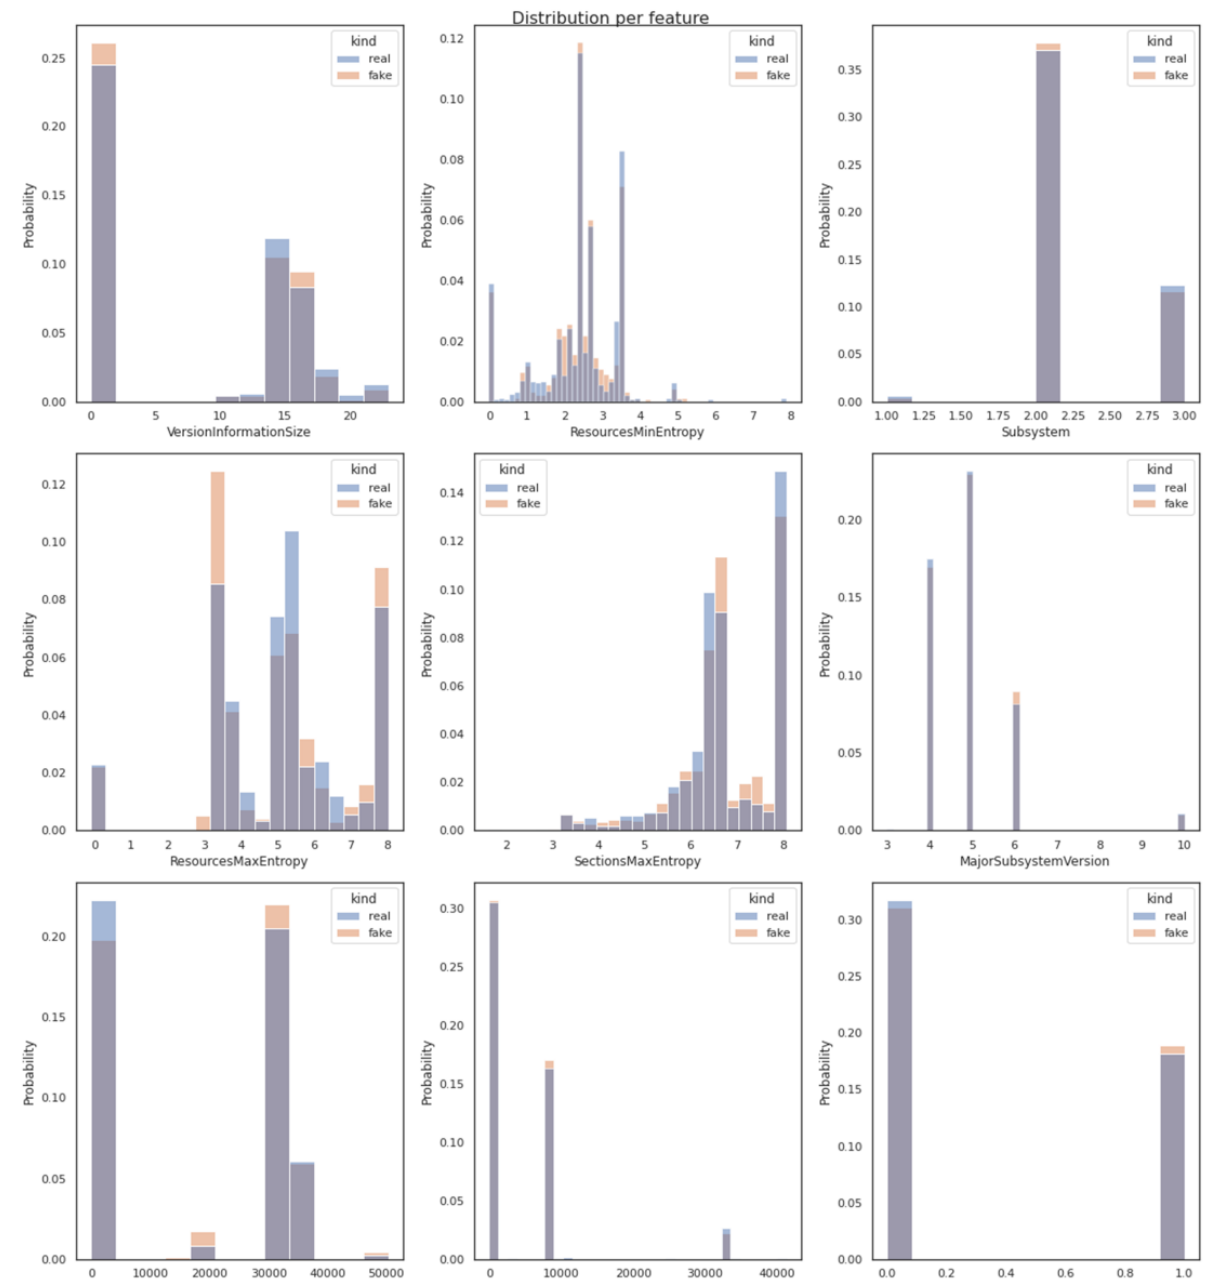
Figure 6. Similarity of real and fake data samples between pair variables using distribution metrics techniques.